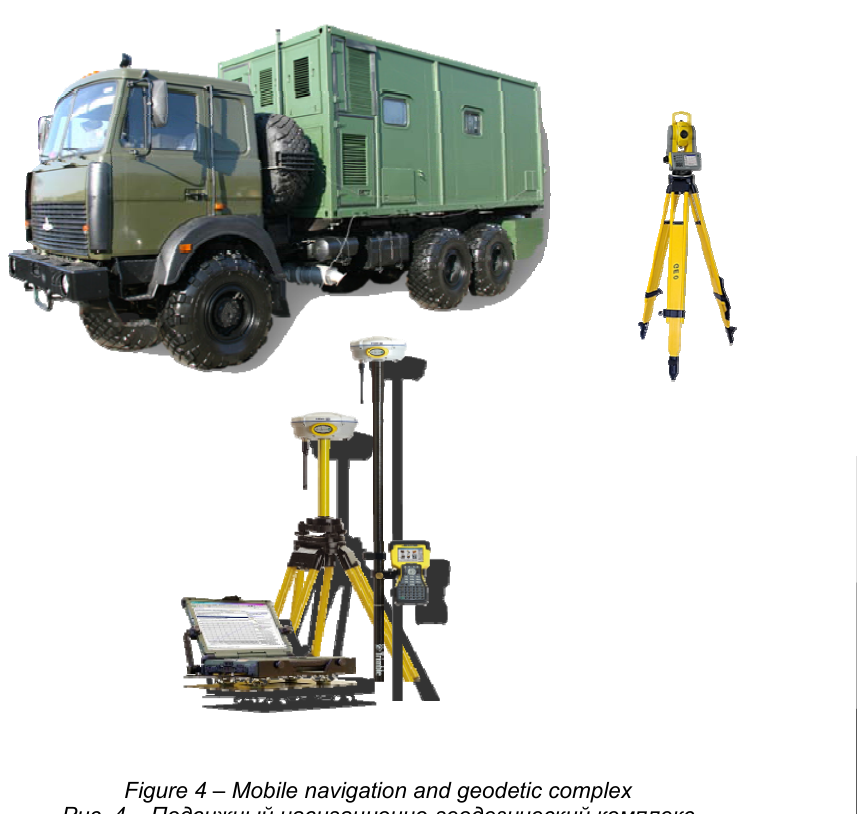
Figure 4 – Mobile navigation and geodetic complex Рис . 4 – Подвижный навигационно - геодезический